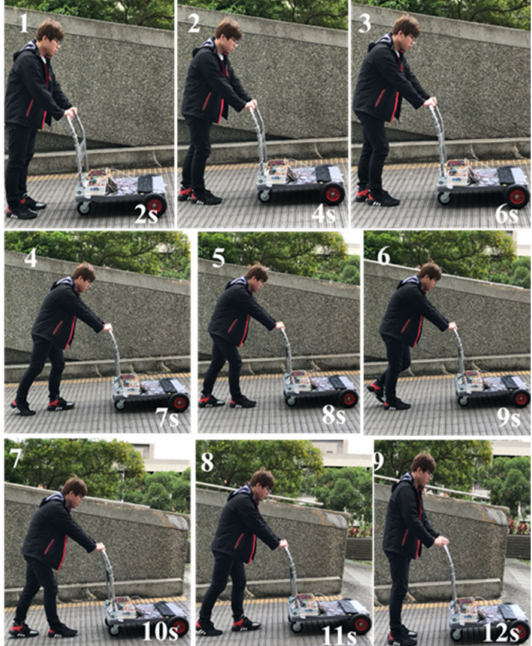
Figure 15. Snapshots of smart walker assisted on a steep uphill.